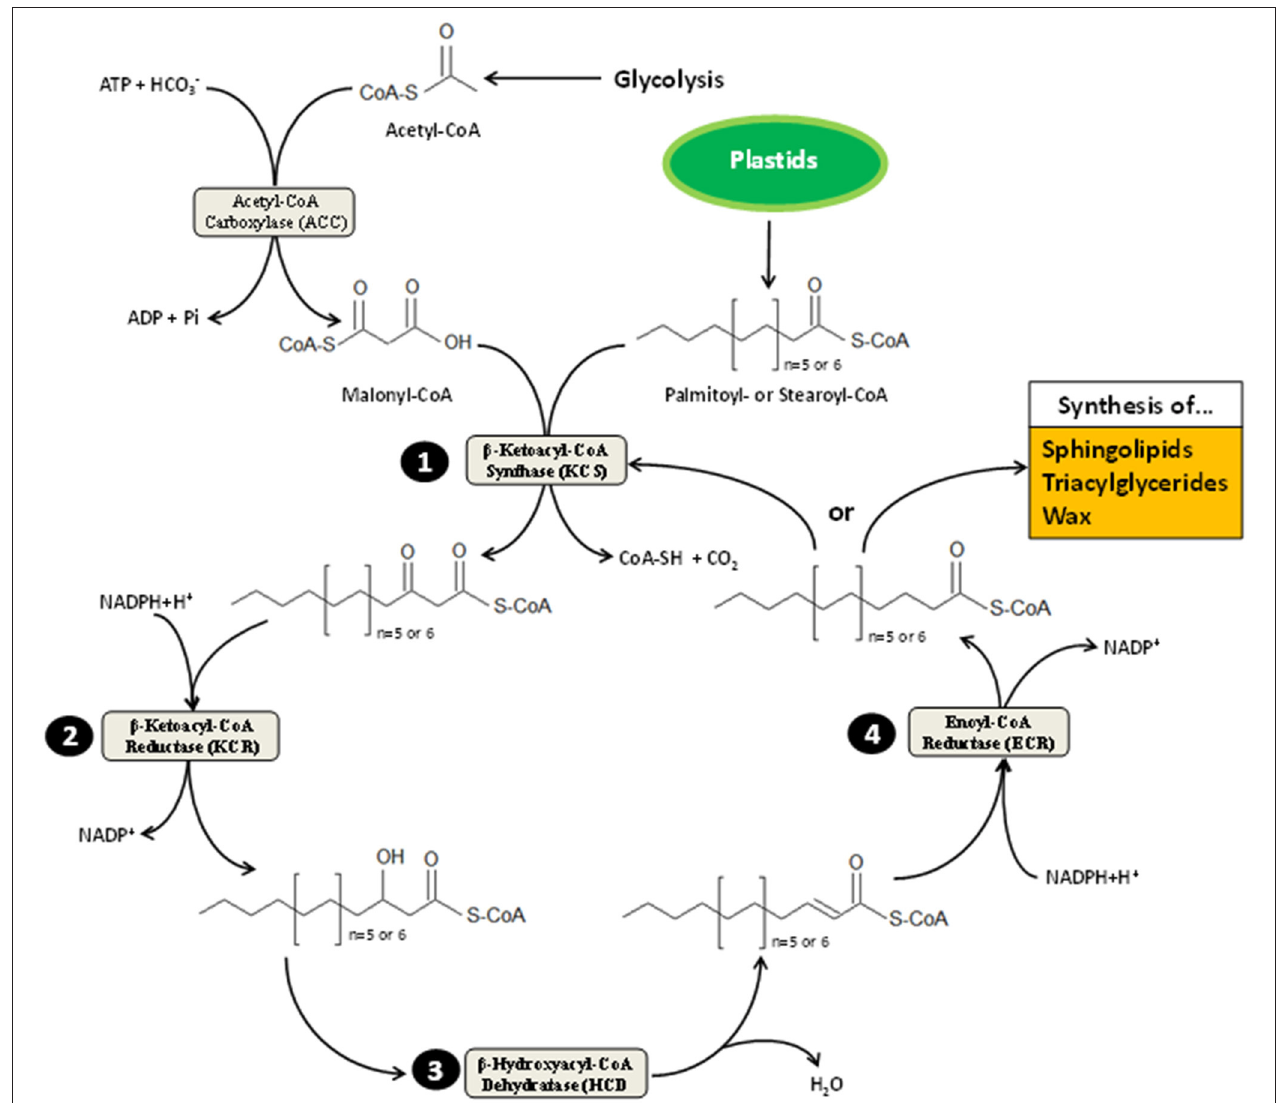
FIGURE 1 | Scheme representation of very-long-chain fatty acid elongation. This process takes place on cytosolic side of the ER membrane. It is alimented by acetyl-CoA and acyl-CoA originating from the cytoplasm-located glycolysis and plastid-resident FA elongation pathway, respectively. Plastids provides 16 or 18 carbon-long acyl-CoA (i.e., palmitoyl- and stearoyl-CoA) to be elongated. The first committed step to VLCFA elongation cycle is catalyzed by the β -ketoacyl-CoA synthase (KCS), which condenses malonyl-CoA (synthesized by carboxylation of acetyl-CoA moieties) with palmitoyl- or stearoyl-CoA. Resulting products are then reduced into β -hydroxacyl-CoA (step 2) before losing a molecule of water (step 3); the latter reaction of which is mediated by the β -hydroxacyl-CoA dehydratase (HCD). Upon dehydration, β -enoyl-CoA undergo reduction (step 4), forming acyl-CoA that harbor two additional carbons. These products can either be oriented toward sphingolipid, wax and triacylglyceride synthesis depending on tissue specificity and cell requirement or reenter VLCFA elongation cycle until its length reaches 28 carbons in Arabidopsis or more in other plant species. Each cycle turn consumes one molecule of ATP and two of NADPH + H +